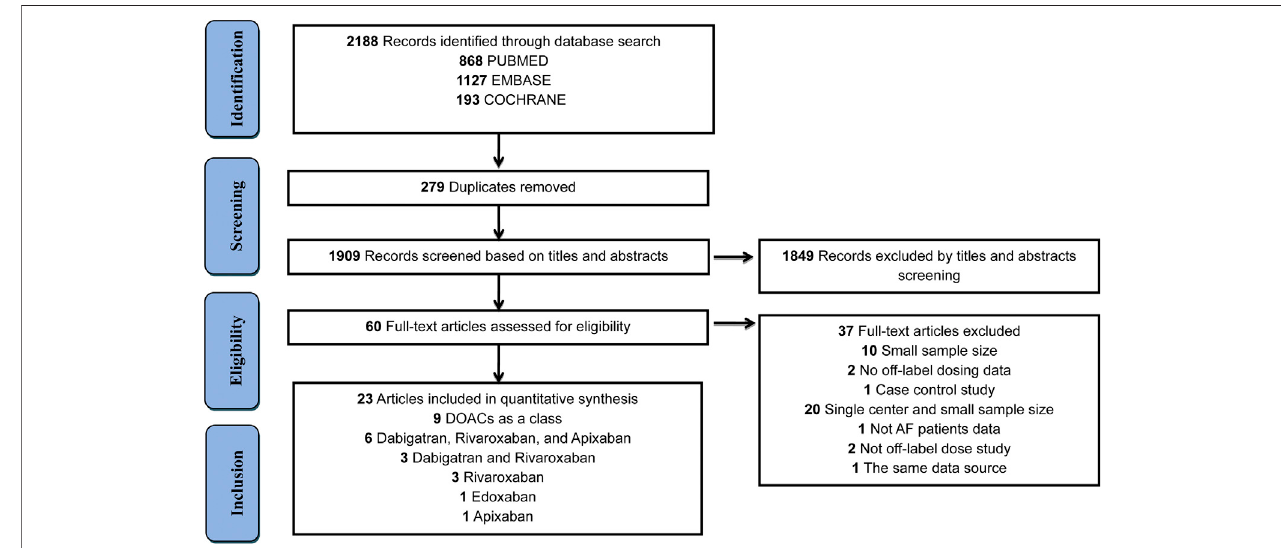
FIGURE 1 | Flow diagram for the selection of eligible studies. DOACs: direct oral anticoagulants.